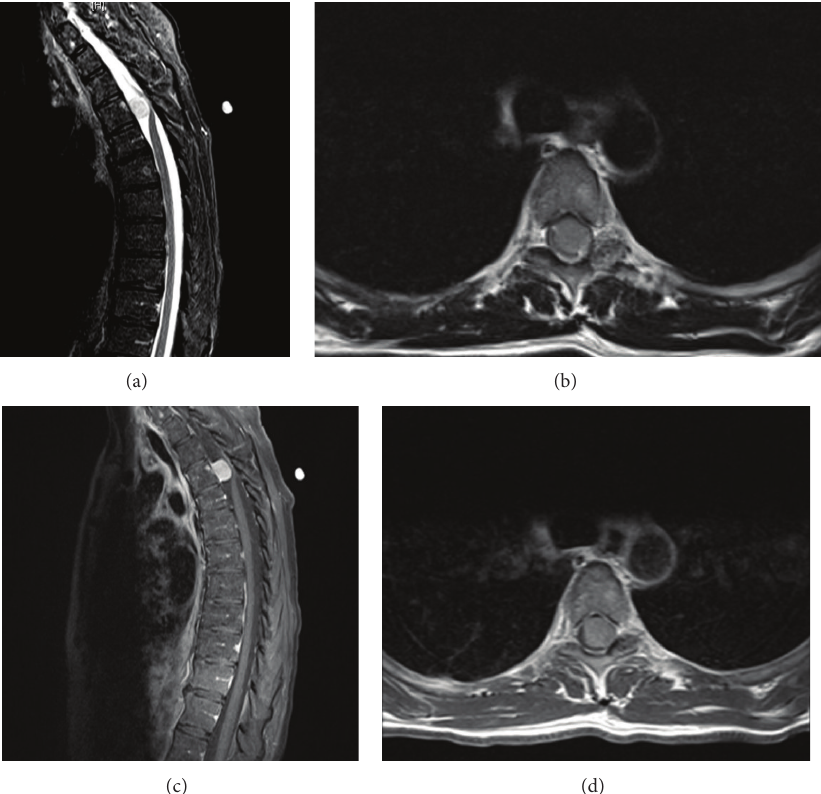
Figure 1: (a) Pre-op sagittal T2 MRI, meningioma at T4 level. (b) Pre-op axial T2 MRI, meningioma at T4 level. (c) Pre-op sagittal T1 MRI with contrast, meningioma at T4 level. (d) Pre-op axial T1 MRI with contrast, meningioma at T4